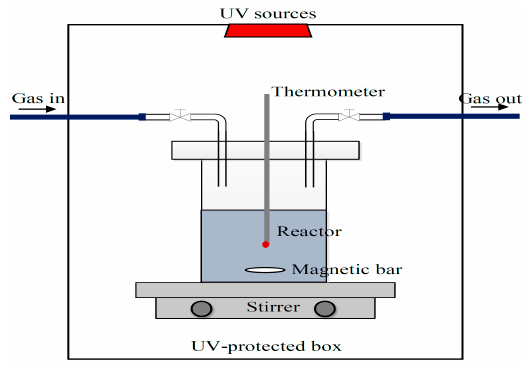
Figure 1. Scheme of the photoreactor.